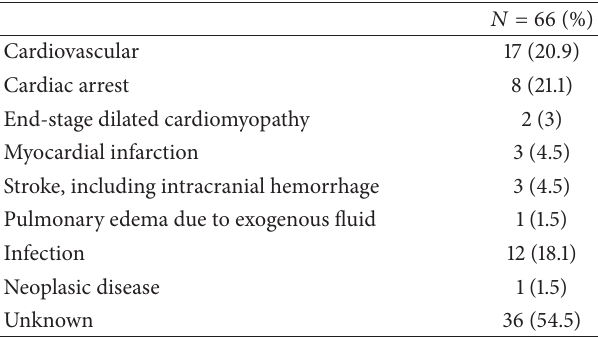
Table 2: Cause of death in the PM